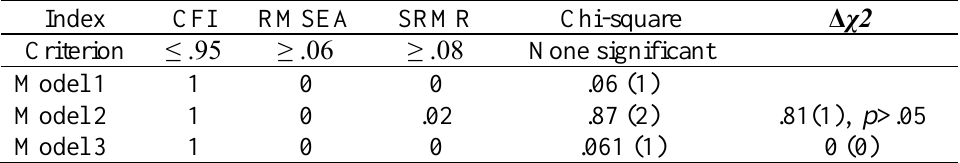
Summary of model fit indices for Zhang